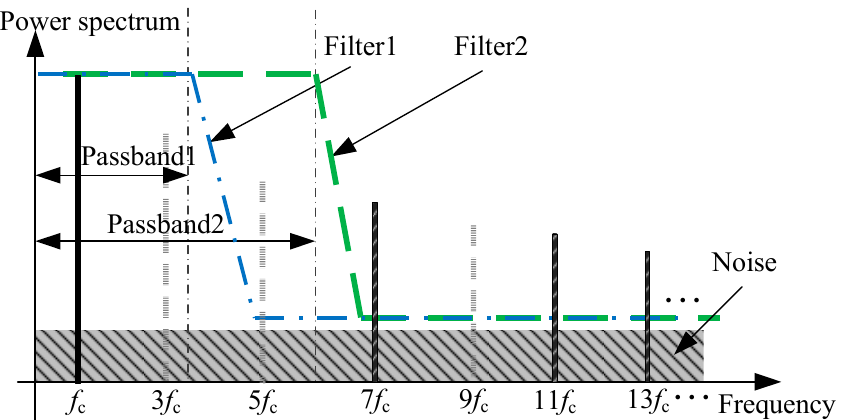
Figure 2. The profile of harmonics when third and fifth harmonics are eliminated in proposed method. In this paper, a five-level RF-PWM method for broadband ADTx is proposed. The method achieves the third and fifth harmonic cancellation of five-level RF-PWM by controlling the pulse width and the center position of the three-level sub-pulses the generation of the five-level RF-PWM signal by changing the threshold signals. Compared with existing RF-PWM methods, the method proposed in this paper can achieve simultaneous elimination of the third and fifth harmonics, relax the requirement for output filters and improve the broadband performance of ADTx.